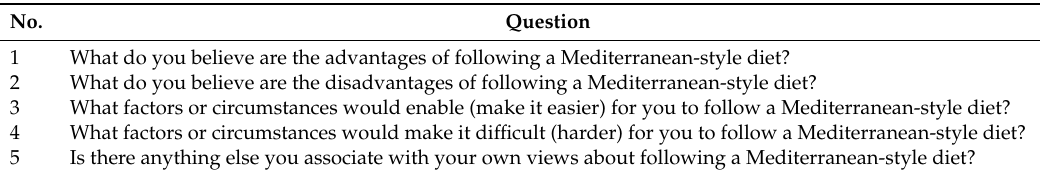
Table 1. Survey questions to elicit attitudes and perceived barriers and enablers toward following a Mediterranean